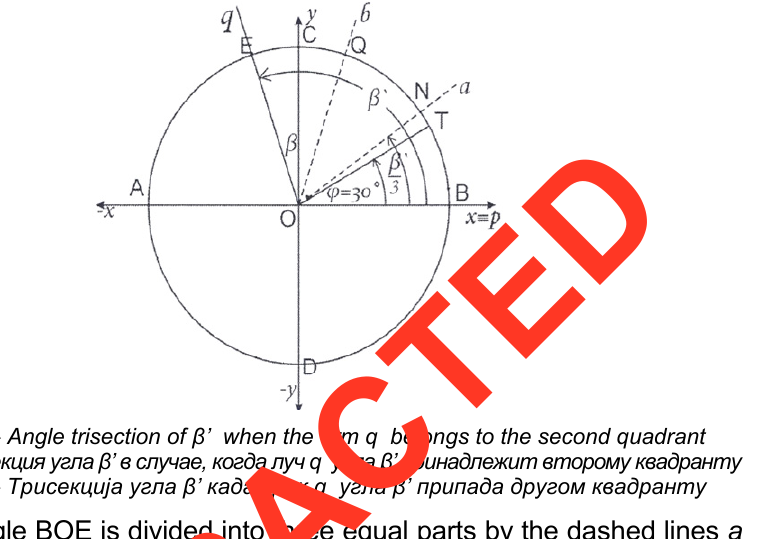
Figure 14 – Angle trisection of β ’ when the arm q belongs to the second quadrant Рис . 14 – Трисекция угла β ’ в случае , когда луч q угла β ’ принадлежит второму квадранту Слика 14 – Трисекција угла β ’ када крак q угла β ’ припада другом